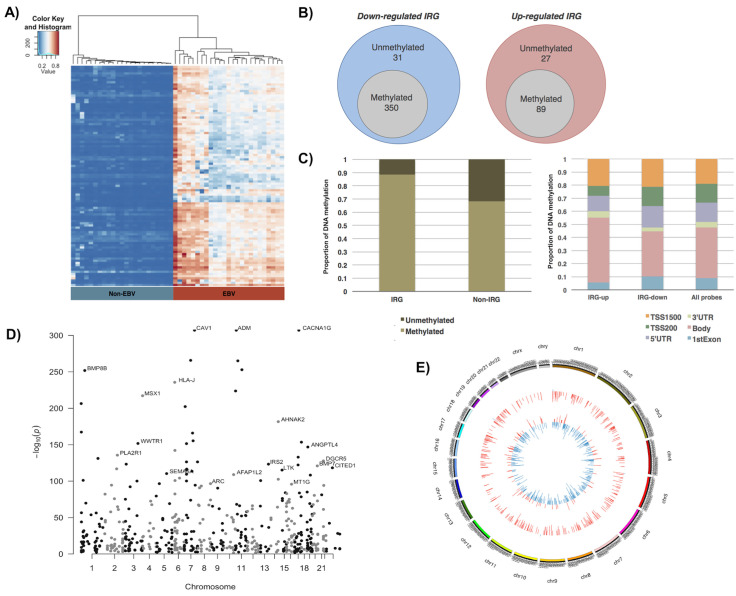
DNA methylation analysis of IRGs in EBVaGC.(A) Heat map showed the hierarchical clustering of all differentially methylated (DE) IRGs, comparing between EBV-positive (right, red) and EBV-negative (left, blue) GC samples. (B) Venn diagram showed the number of DE IRGs (grey circle) for both down-regulated IRGs (left, blue circle) and up-regulated IRGs (right, red circle). (C) (Left panel) Bar graph showed the proportion of methylated and unmethylated genes in deregulated IRG and non-IRG groups. (Right panel) Stacked bar graph showed the distribution of methylated CpG probes at different regions, including TSS1500 (orange), TSS200 (green), 5’UTR (purple), 3’UTR (light green), gene body (pink), and 1st Exon (blue), for up-regulated and down-regulated IRGs in EBVaGC. TSS200: 200bp upstream of transcription start site (TSS); TSS1500: 200-1500bp upstream of TSS. Proportion of each regions in the whole array is included. (D) Manhattan plot showed the chromosomal localization (x-axis) and log-base of adjusted p-value (y-axis) of all differentially methylated IRGs in EBVaGC. Examples of top methylated IRGs were annotated. (E) Circos diagram of all IRGs in EBVaGC depicts the methylation pattern in the outer circle (hypomethylated or hypermethylated gene position is displayed as blue or red respectively), and the transcriptional pattern in the inner circle (down-regulated or up-regulated gene position is displayed as blue or red respectively).